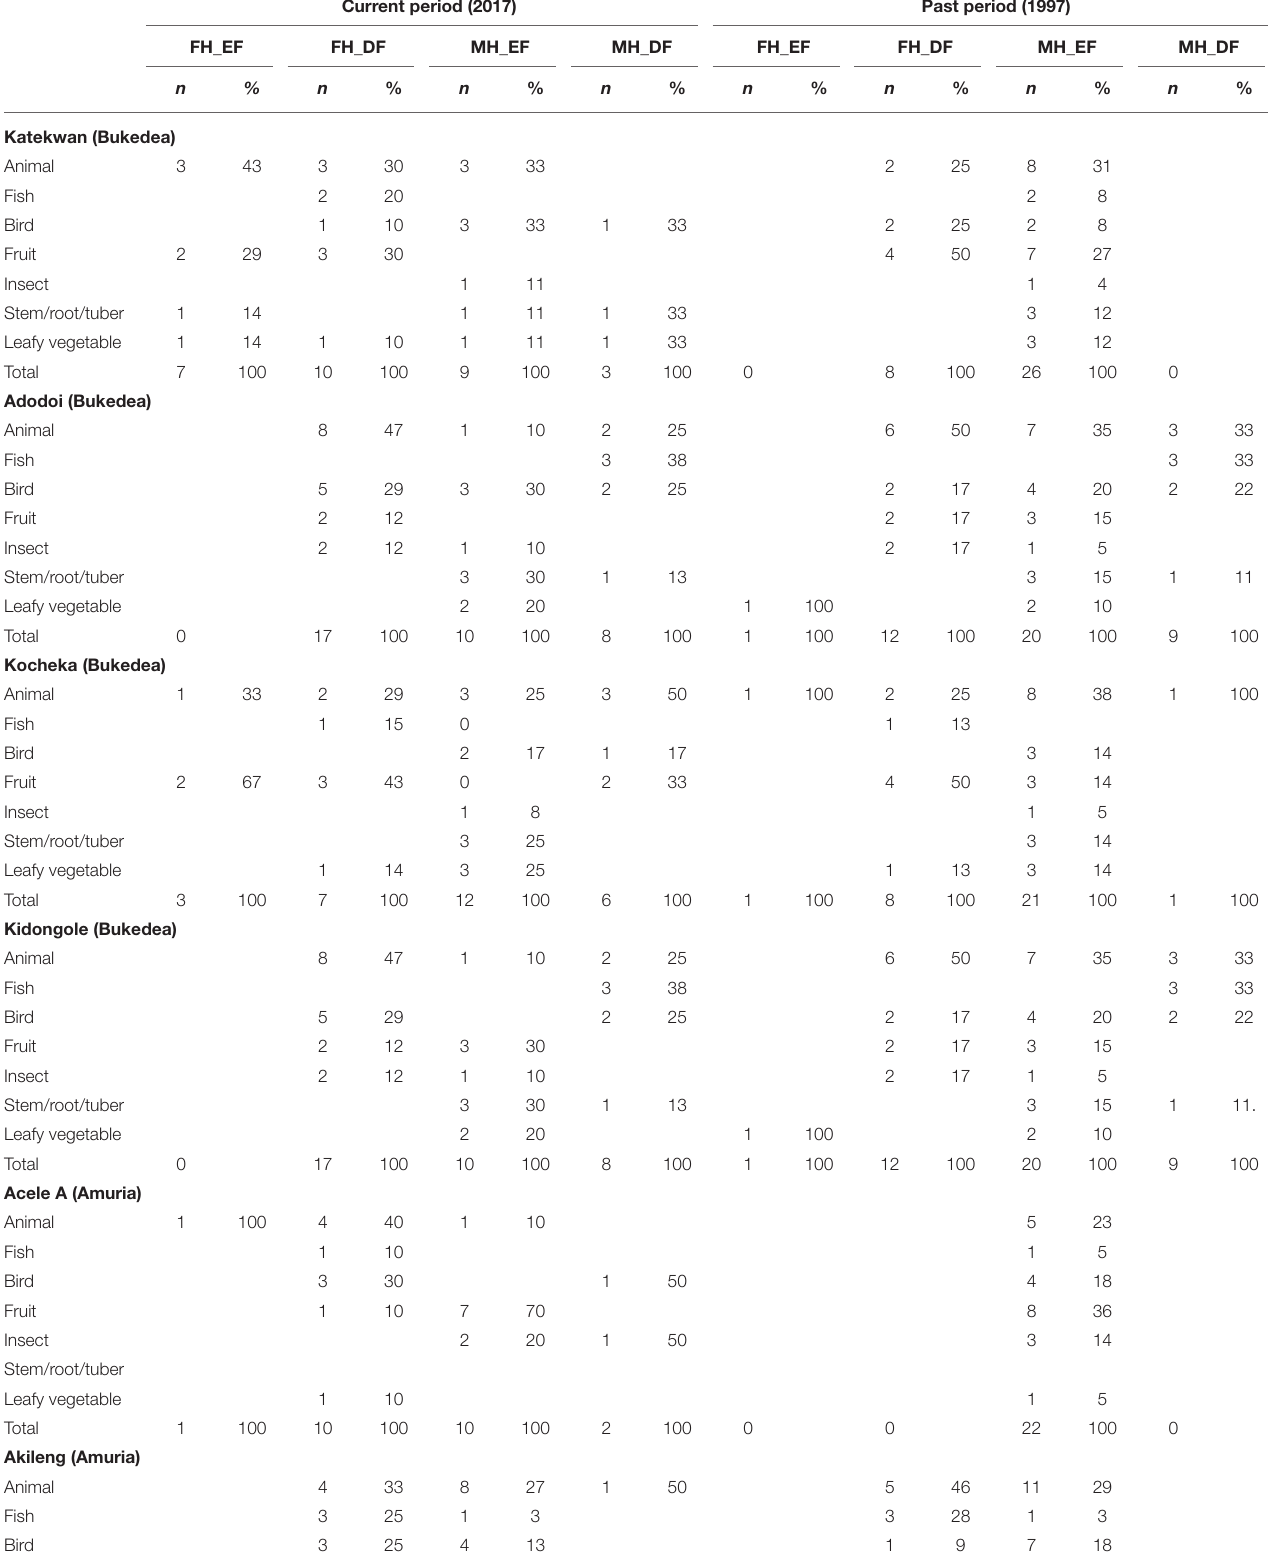
TABLE 3 | Availability species according to the 4-cell placement for the current and past period for Teso sub-region according to village. Current period